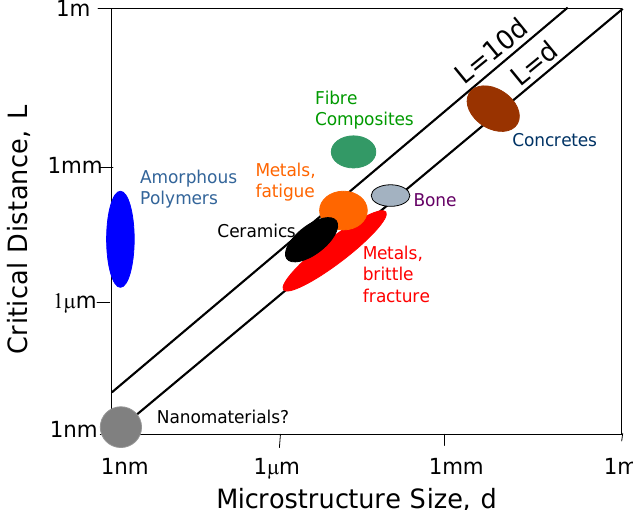
Figure 6: Values of L and d in various classes of